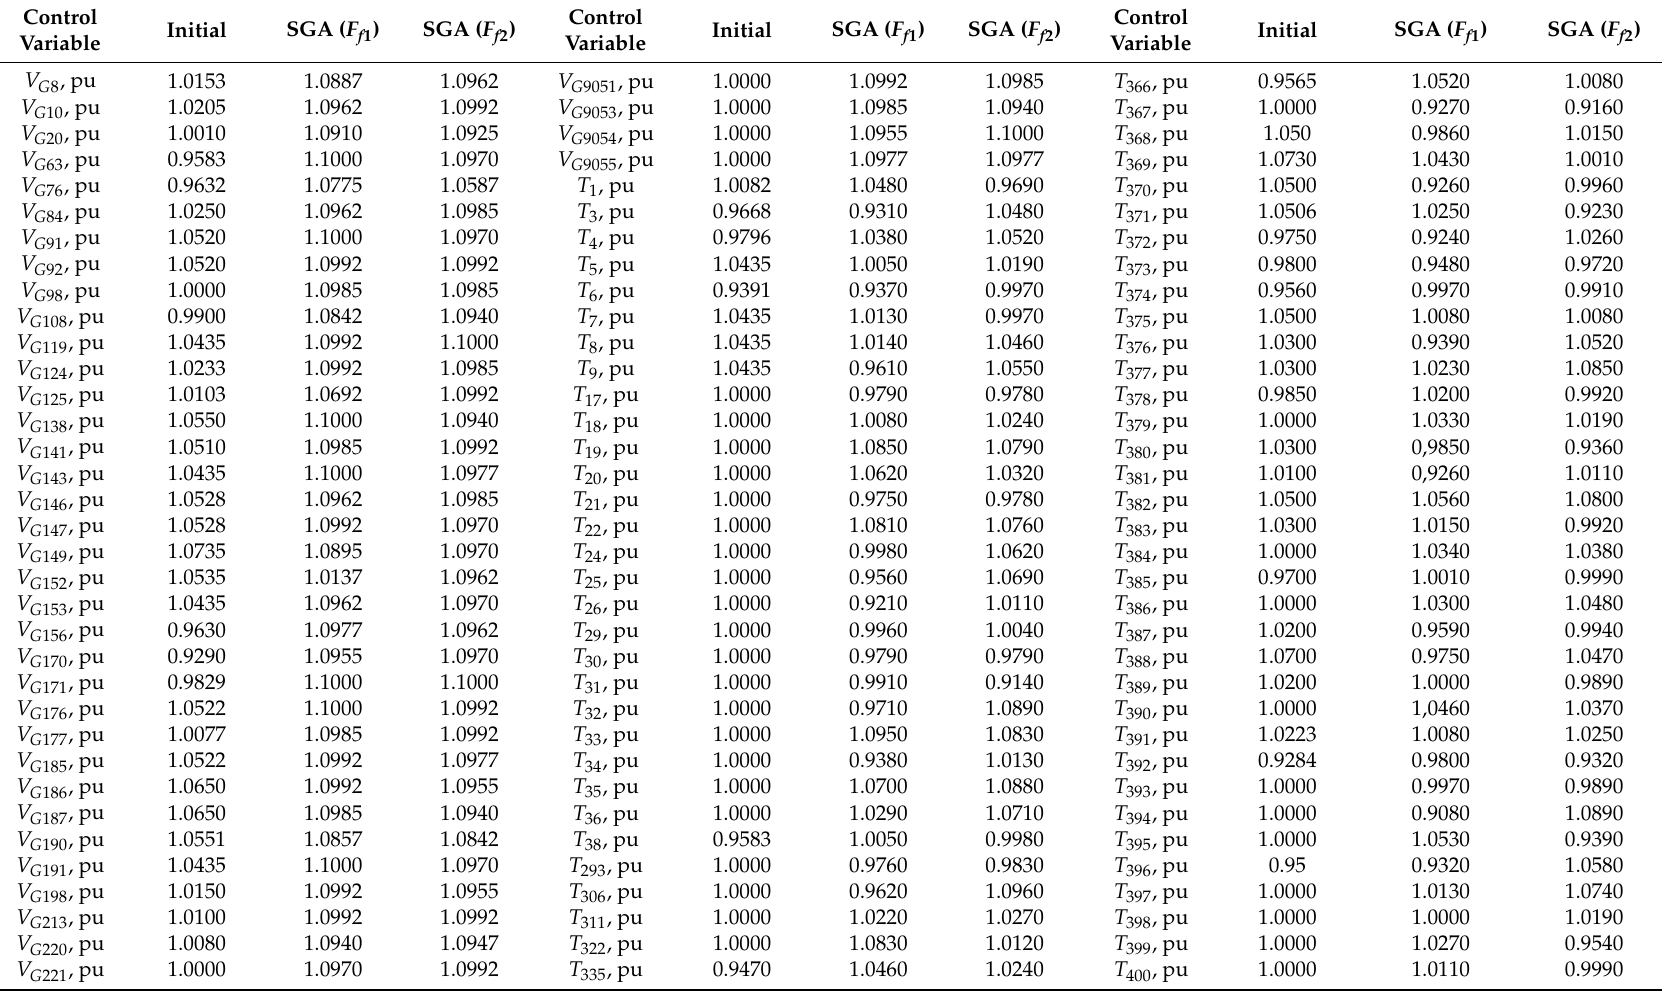
Table 8. Best control variable settings for power loss minimization of IEEE 300 bus test